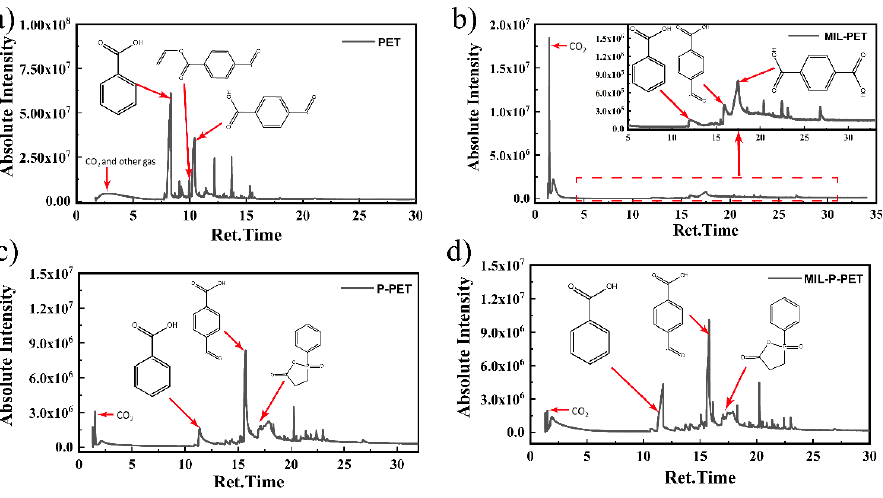
Figure 10. Py − GC − MS spectra of ( a ) PET, ( b ) MIL − PET, ( c ) P − PET, ( d ) MIL − P − PET. Figure 10. Py-GC-MS spectra of ( a ) PET, ( b ) MIL-PET, ( c ) P-PET, ( d )